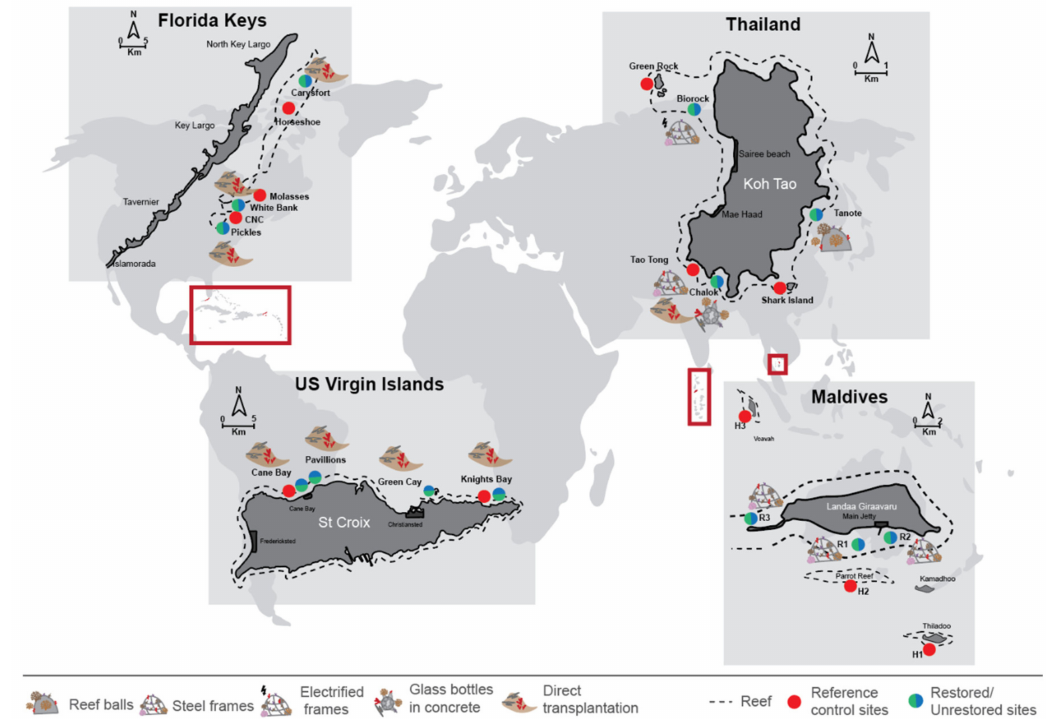
Figure 1. Map showing the locations of the four coral restoration programs surveyed and an overview of the restoration strategies used in each program (see key at bottom of figure to interpret diagrams that represent techniques present at each site). Half green and half blue circles indicate adjacent restored and unrestored sites; red circles indicate control reference